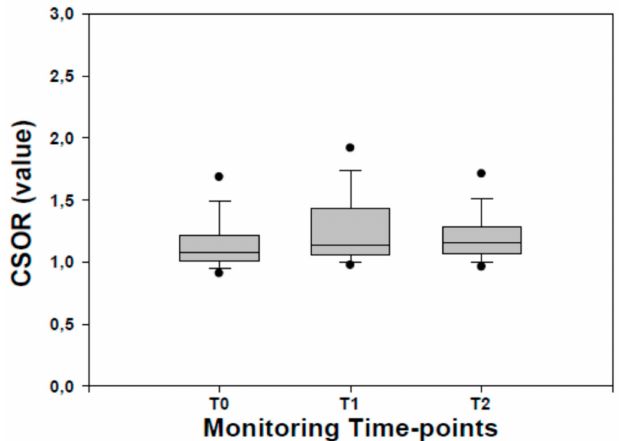
Figure 5. Cerebral–splanchnic ratio (CSOR) values recorded in late preterm infants before (T0) during (T1) and after (T2) osteopathic manipulation treatment. Data are given as median and 25–75 ◦